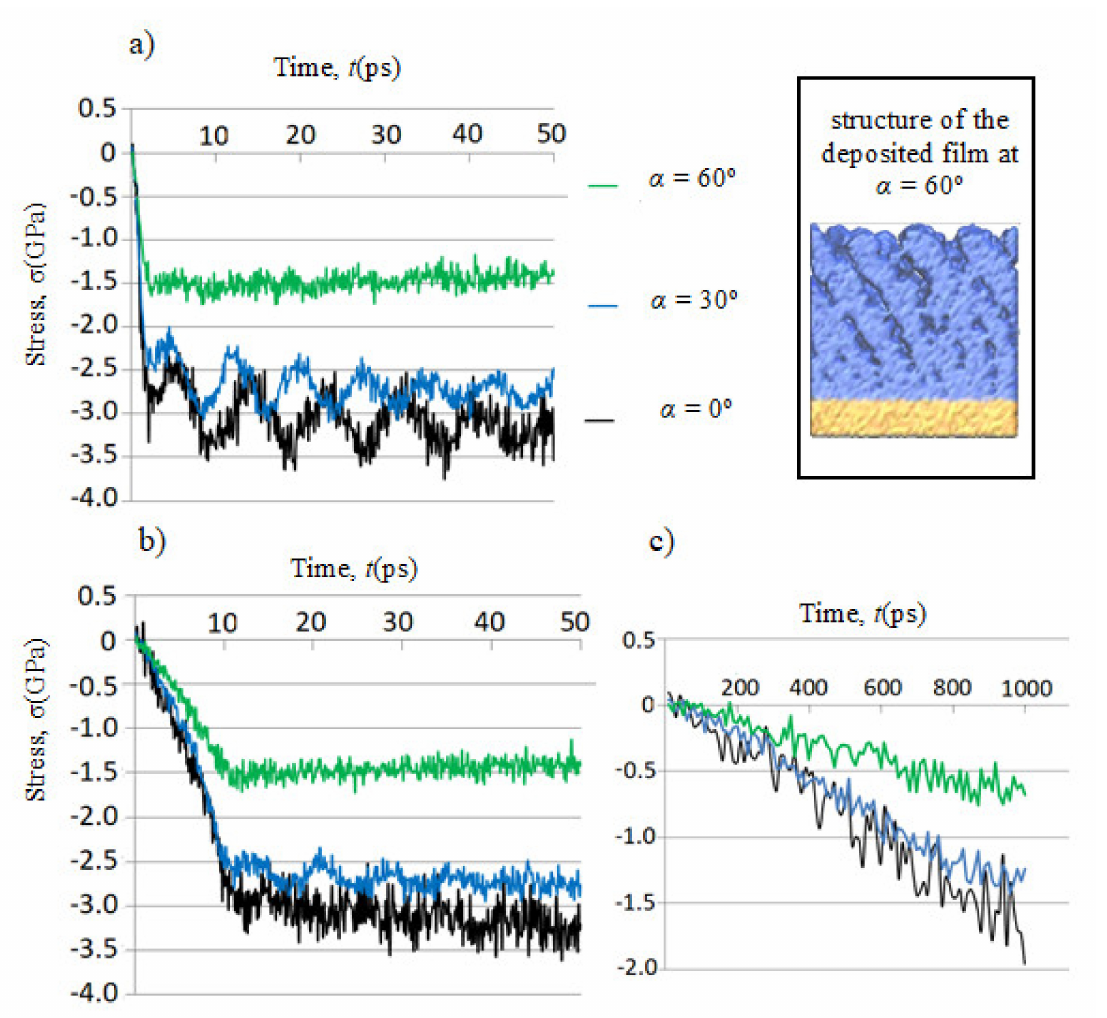
Figure 3. Heating-induced stresses in high-energy-deposited silicon dioxide films. Energy of the incoming silicon atoms E(Si) = 10 eV, α is the deposition angle, τ is the heating time, ( a ) τ = 1 ps; ( b ) τ = 10 ps; ( c ) τ = 1 ns. Heating temperature T f = 1300 K. The atomistic structure of the GLAD film is shown in the upper right